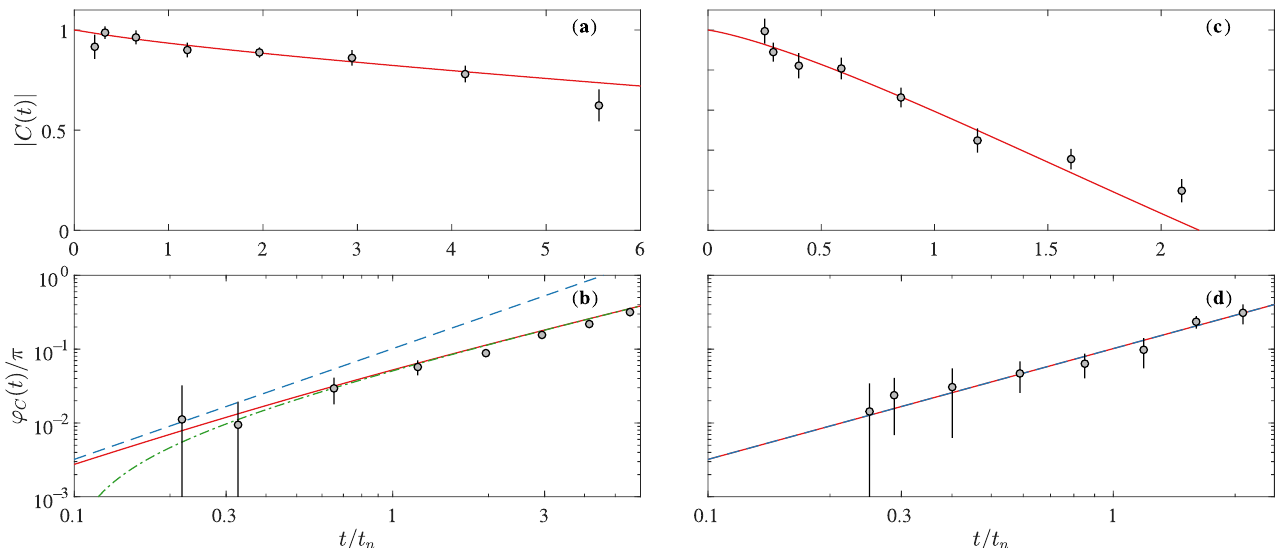
Figure 2. Two-body dynamics at weak and unitary interaction strengths. The coherence amplitude (top row) and phase evolution (bottom row) at 1/ k n a = − 1.8 ( a , b ) and 1/ k n a = 0.01 ( c , d ). The corresponding data were previously presented in Ref. [20]. Equation (1) is shown as a solid red line and the two limits in Equation (2) are shown as a dashed blue line and a dash-dotted green line for the universal and the weak coupling dynamics, respectively. Note that the universal description coincides with the general two-body model in panel ( d ). The errors correspond to fit